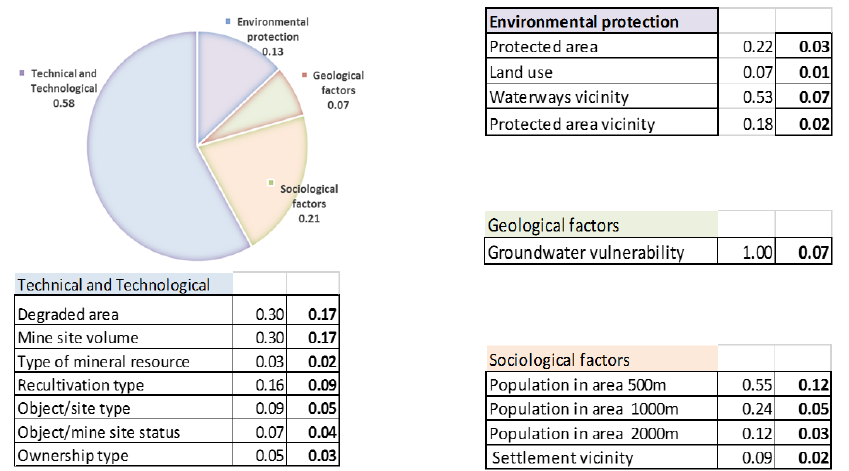
Figure 6. The weight coefficients.